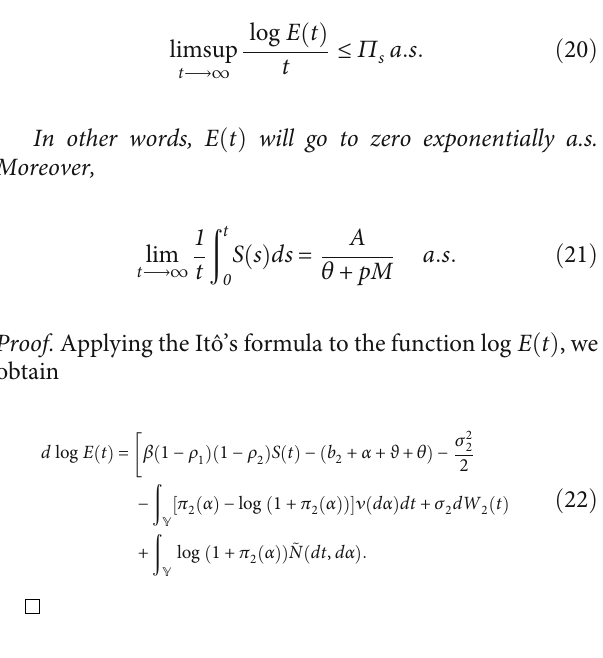
ð α Þ = 0 : 01 , π = 0 : 2 , σ = 0 : 2 , σ = 0 : 1 , σ = 0 : 1 , σ = 0 : 1 , π 1 2 3 4 5 1